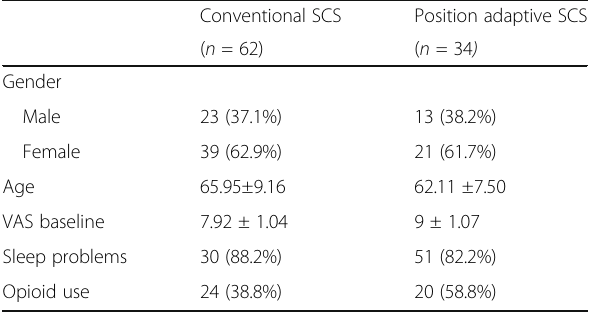
Table 1 General characteristics of the study population a